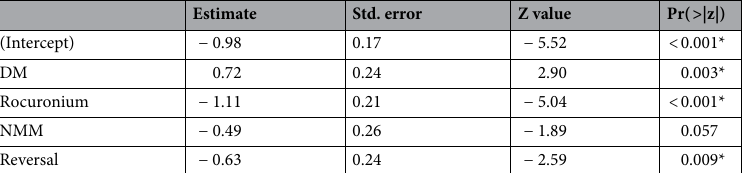
Table 3. Variables and coefficients of the generalized linear model with likelihood-ratio test to predict early postoperative pulmonary complications (hypoxemia and airway obstruction). The table shows the model coefficients, the standard error (Std. Error), the corresponding Z value, and related P values. The most interesting thing is the sign of the coefficients of each of the variables since it indicates the direction of the influence in the response. DM Diabetes Mellitus, NMM neuromuscular monitoring; *Significance defined as Pr( >|z|) < 0.05.